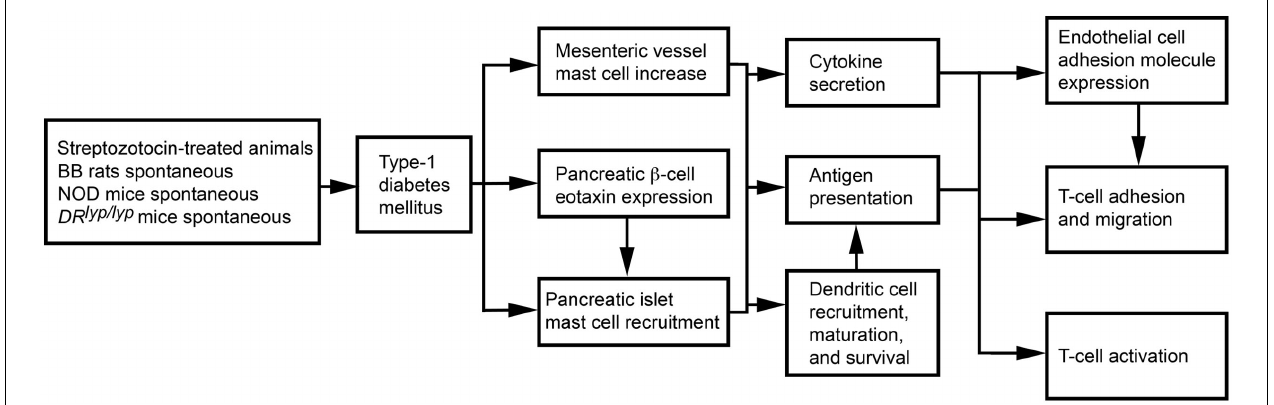
FIGURE 4 | Mast cell activities in streptozotocin-induced and spontaneous type 1 diabetes